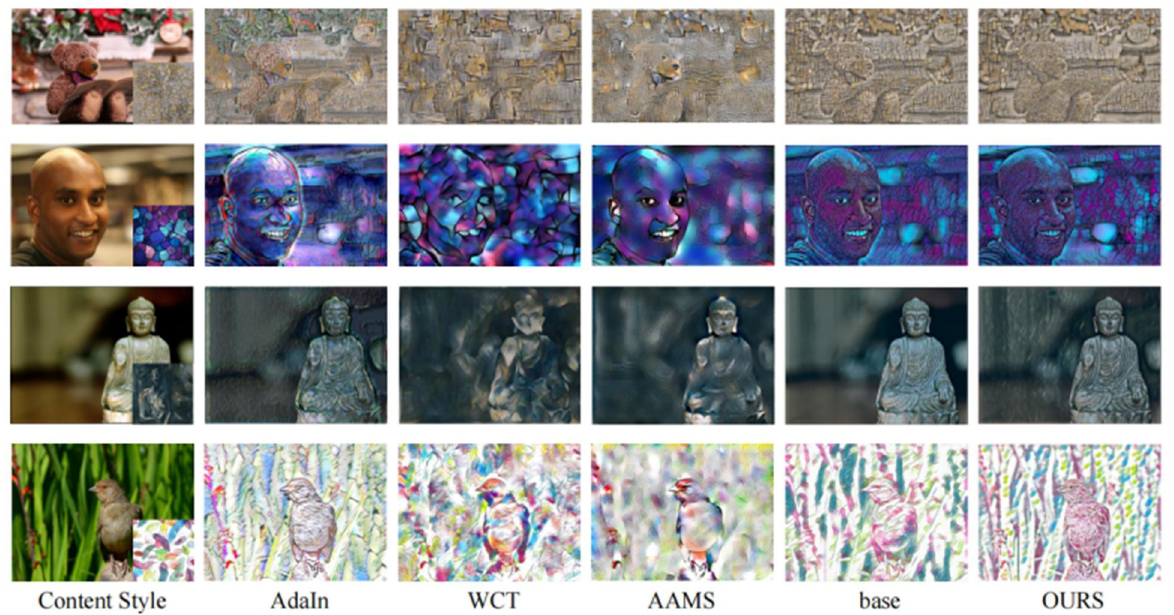
Fig 5. Comparison of results generated by the various methods.